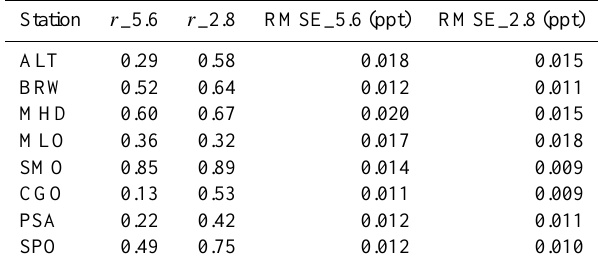
Table 1. Pearson’s correlation value ( r _5.6 and r _2.8) and root- mean-square error (RMSE_5.6 and RMSE_2.8) for modelled and observed seasonal cycle of SF 6 at eight surface stations, shown in Fig. 2, for two different model grid